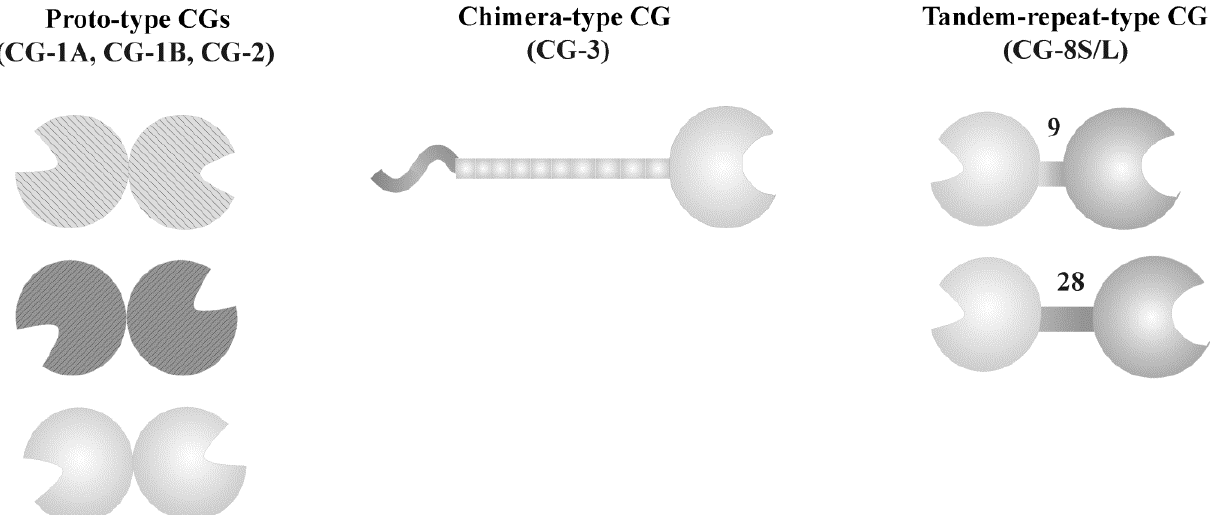
Figure 1. Schematic illustration of the three types of spatial CRD presentation in galectins, using the five chicken galectins as example. The ten Gly/Pro-rich repeats in CG-3 and the lengths of the linker peptide in CG-8 given in number of amino acids are indicated (from [66], with